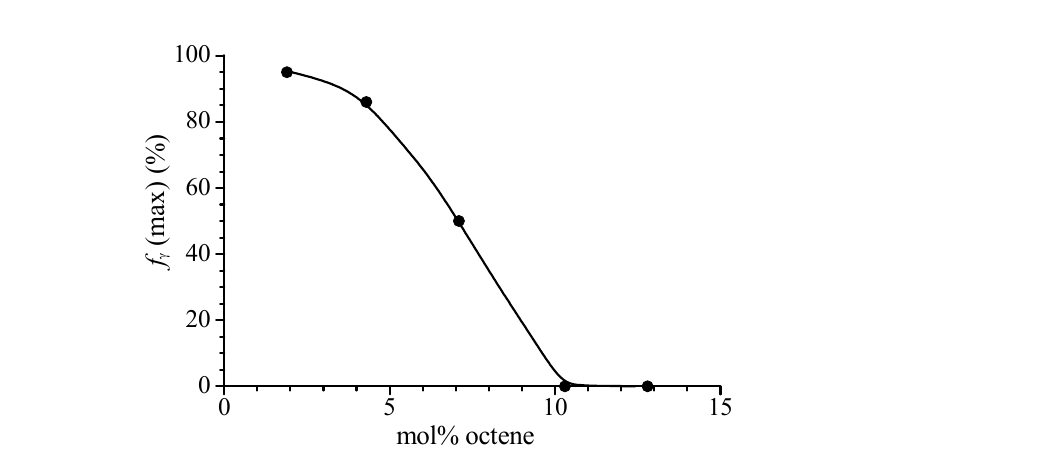
Figure 5. Maximum amount of γ form ( f γ (max)) obtained in isothermal crystallization from the melt of iPPC8 copolymers (the highest values of Figure 4) as a function of octene concentration. The data of the maximum amount of γ form of iPPC8 copolymers of Figure 5 are also plotted in Figure 6 as a function of the total concentration of defects, defined as the sum of steric defects ( rr diads), 2,1 regiodefects, and octene units, ε = [ rr ] + [1,2] + [octene], and compared with the values of f γ (max) observed and found in the literature for highly stereoregular iPP homopolymer [72,74,93,115], iPPC2 [72], iPPC4 [72], iPPC5 [93], and iPPC6 [74] copolymers. The literature values refer to copolymers synthesized with similar isospecific catalysts [72,74,93,115] that produce copolymers with isotacticity as high as that of the iPPC8 copolymers analyzed in this paper. Therefore, the differences among the different copolymers observed in Figure 6 are due to the different effects of the different comonomers on the crystallization of the α and γ forms. In the plot of Figure 6, the data of maximum amount of γ form produced by melt crystallizations of stereodefective iPPs containing different amounts of defects of stereoregularity (only rr diad defects) synthesized with various metallocene catalysts are also reported [110]. Figure 6 shows that, compared to the homopolymer sample of similar high isotacticity synthesized with the same or similar catalyst, for all copolymers the maximum amount of γ form rapidly increases with increasing comonomers concentration. For iPPC8 copolymers, the increase of f γ (max) from that of the homopolymer is very fast, and the highest value of f γ (max) is achieved at a very low octene concentration of 1.9 mol%. Then, for octene contents higher than 1.9 mol%, f γ (max) decreases (Figures 5 and 6).